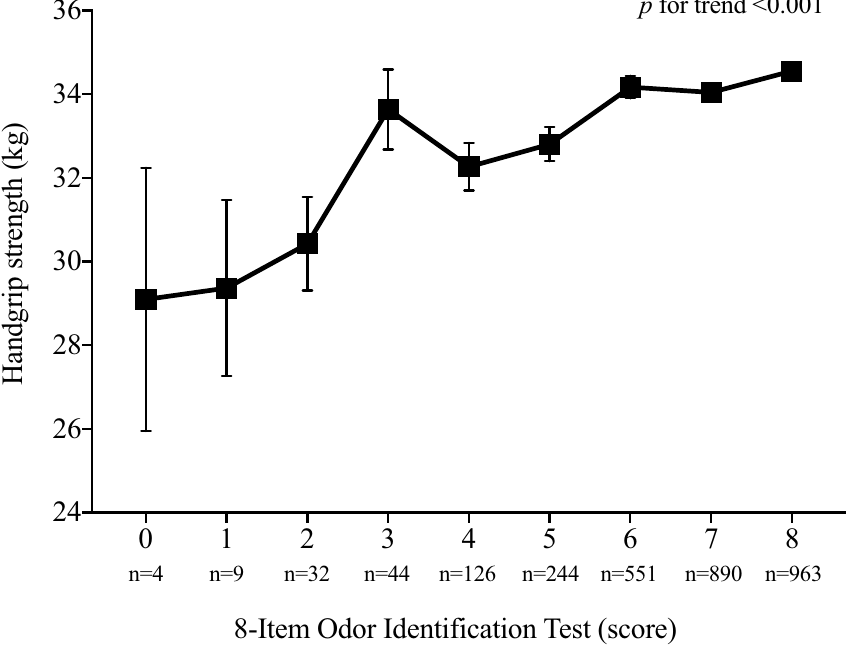
Figure 2. Differences between mean absolute handgrip strength according to the number of positive identifications on the 8-item odor identification test. Adjusted by sex, race/ethnicity, ratio family income to poverty, marital status, education level, dietary intake, smoking status, alcohol consumption and self-reported chronic diseases.